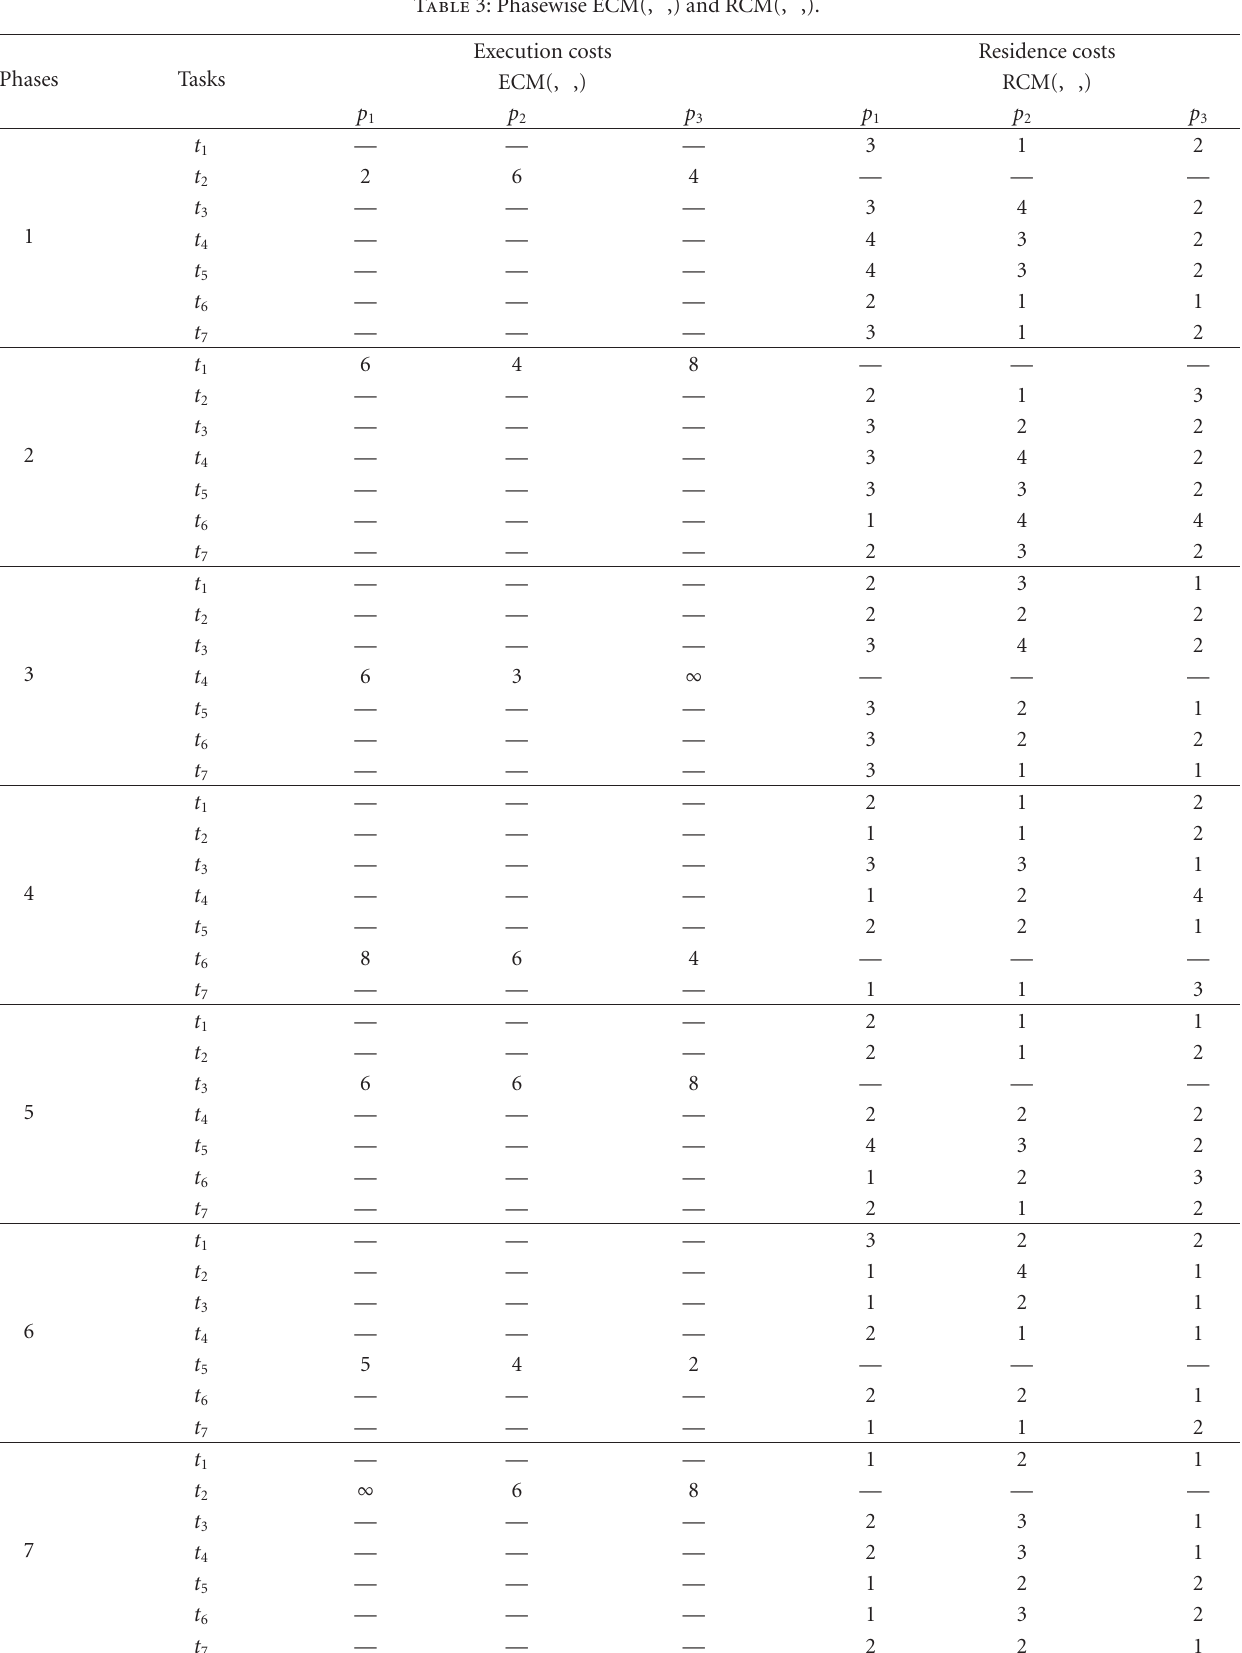
Table 3: Phasewise ECM(, ,) and RCM(,